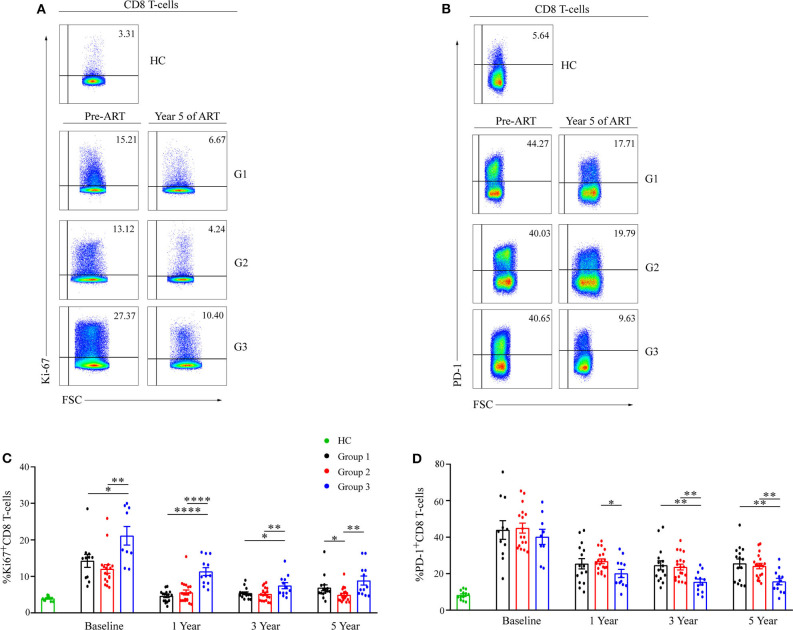
Ki67 and PD-1 expression on CD8 T-cell during ART. Representative flow cytometric data of Ki67 (A) and PD-1 (B) staining gated on CD8 T-cells. Comparisons of mean (SEM) of the percentages of Ki67 (C) and PD-1 (D) expressions on CD8 T-cells between groups during ART. Group 1 (G1, n = 15 participants, 4 missing data at baseline), Group 2 (G2, n = 19 participants, 2 missing data at baseline), Group 3 (G3, n = 12 participants, 3 missing data at baseline), HC (health controls, n = 12 participants). *P < 0.05, **P < 0.01, ****P < 0.0001.